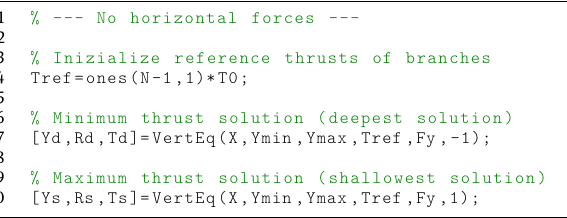
Figure 3: Solving procedure in absence of horizontal forces. The function VertEq is coded as in Figure